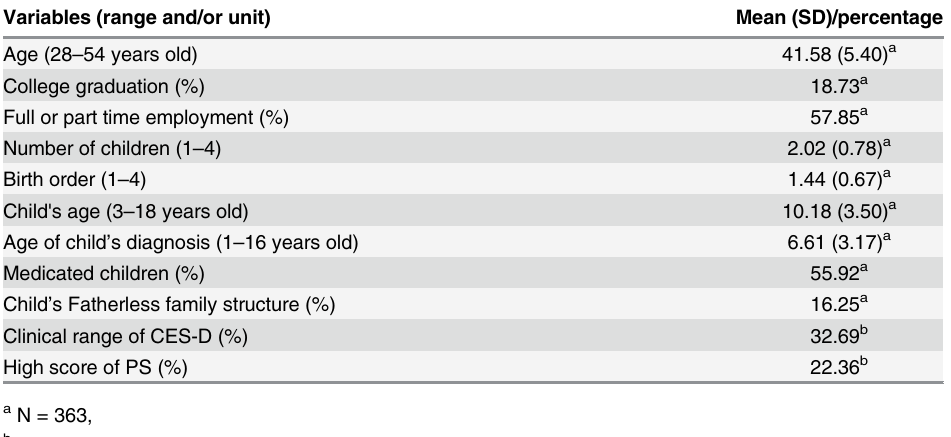
Table 1. Demographic characteristics of participants and their children.